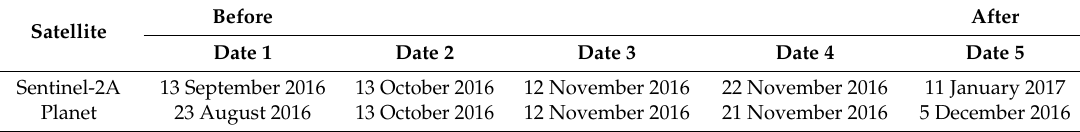
Table 3. Dates of images used prior to and following the fire of 24–25 November 2016.